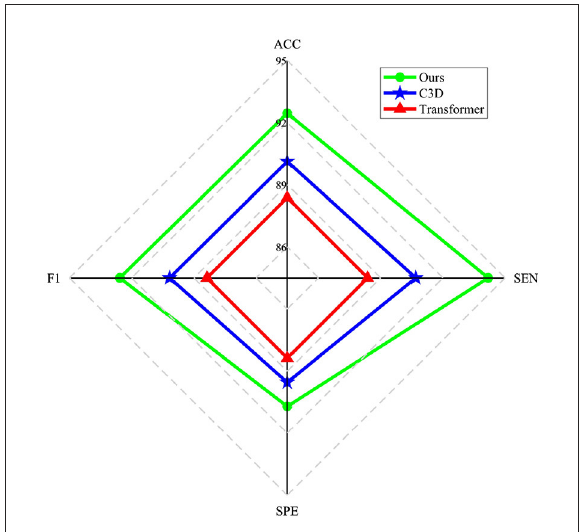
FIGURE12 Influence of different generator structures on the classification performance.